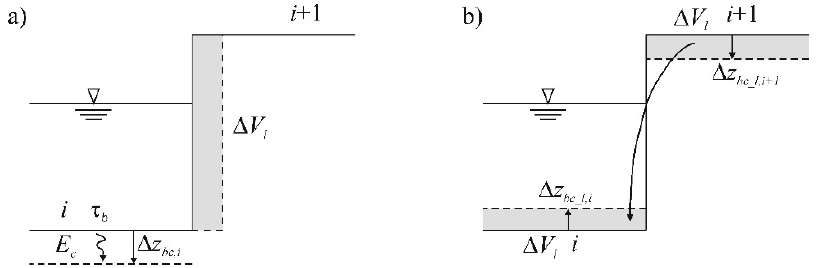
Δ V ∆ V Δ V 2 . 2 . 2 .